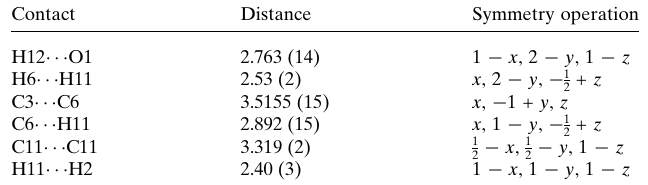
Table 2 Short intermolecular contacts (A˚ ) in the title structure.